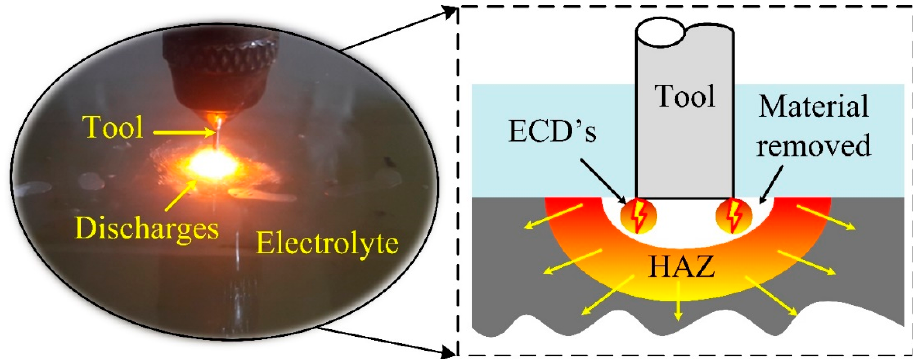
Figure 1. Energy channelization in ECSM process.